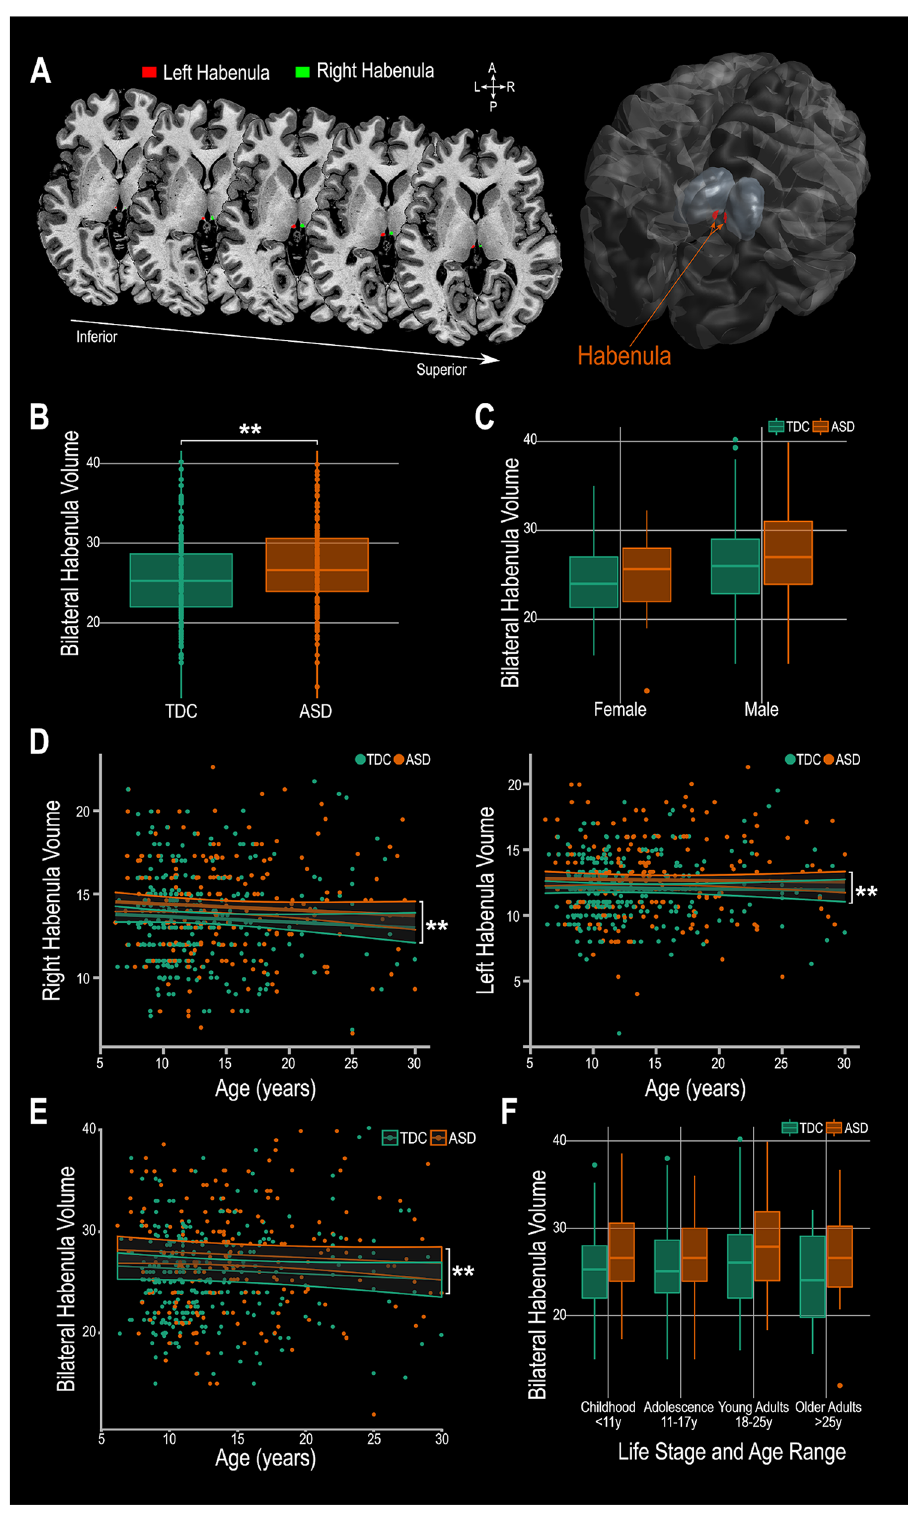
Figure 2. Habenula volume differences found in ASD. ( A ) Example MAGeTBrain habenula segmentation on a T1 weighted magnetic resonance image illustrated on the axial plane and 3D reconstruction of the habenula. ( B ) Bilateral habenula volume is greater in ASD compared to TDC. ( C ) The group effect (bilateral habenula larger in ASD vs TDC) is independent of sex. ( D ) There is no effect or laterality; the habenula is larger in ASD compared to TDC in the right and in the left hemisphere. This effect is apparent across the entire age range tested ( E ) within all age groups ( F ). ** indicates p ≤ 0.01. ASD: autism spectrum disorder subjects; TDC: typically developing